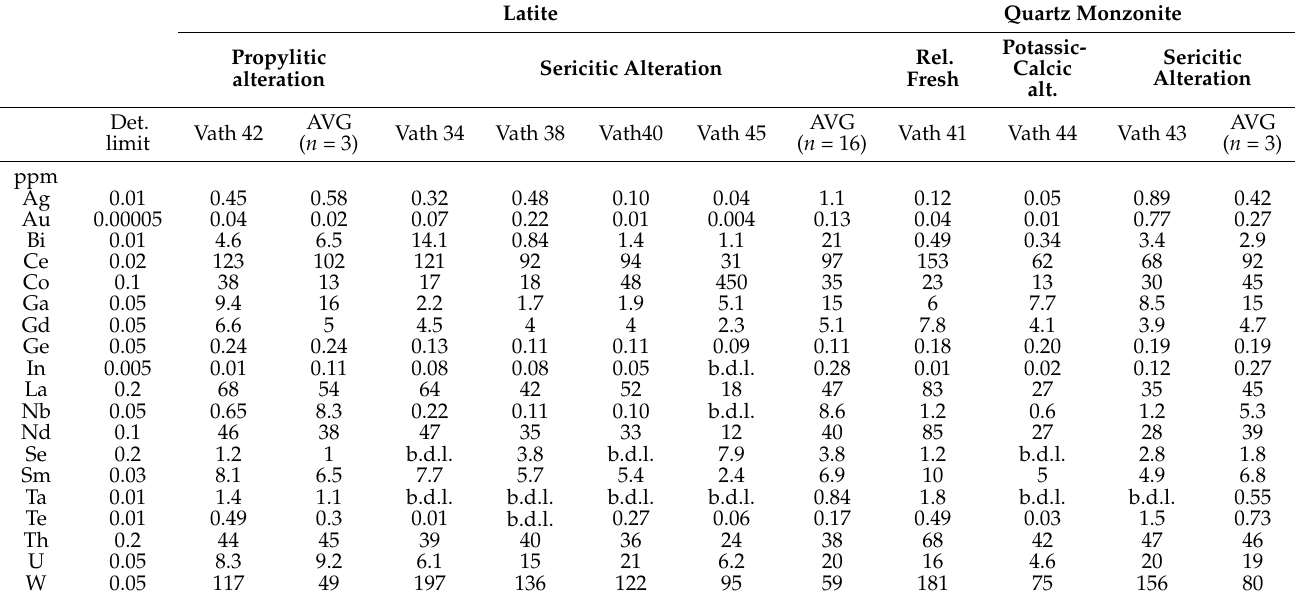
Table 2. Bulk geochemical analyses of selected rare metals from the Vathi porphyry system. The average values of these elements from previously analyzed samples by Stergiou et al. [53] are also given. For the full list of geochemical analyses, see Table S1 in the Supplementary